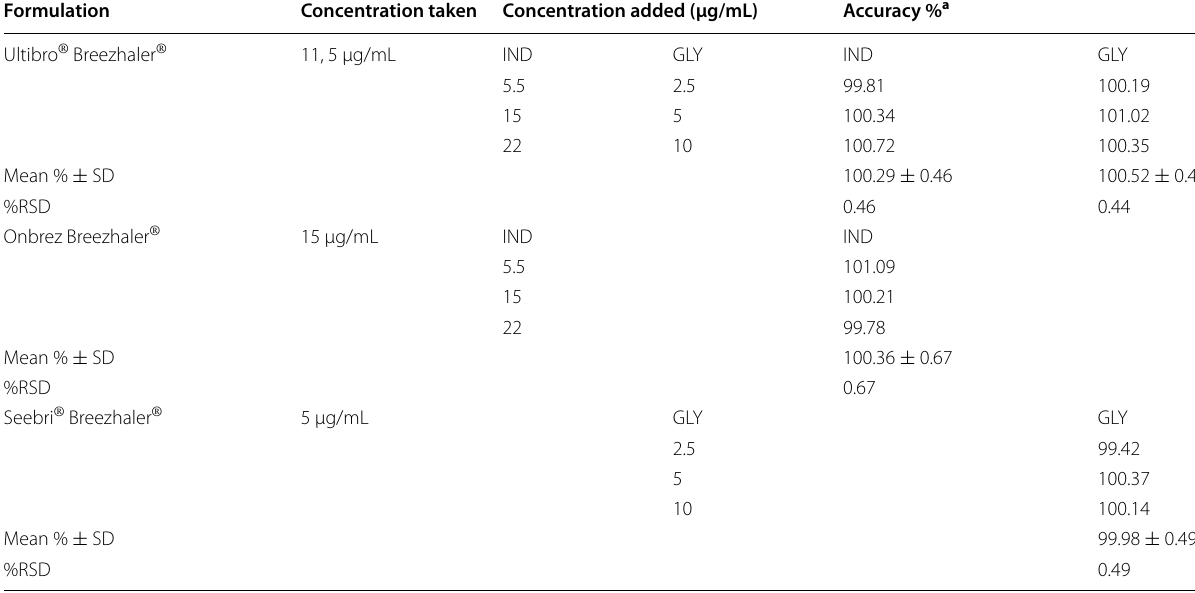
Table 1 Accuracy of the proposed HPLC